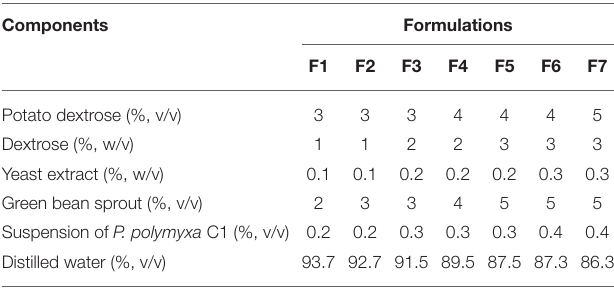
TABLE 1 | Detail components of formulation of P. polymyxa